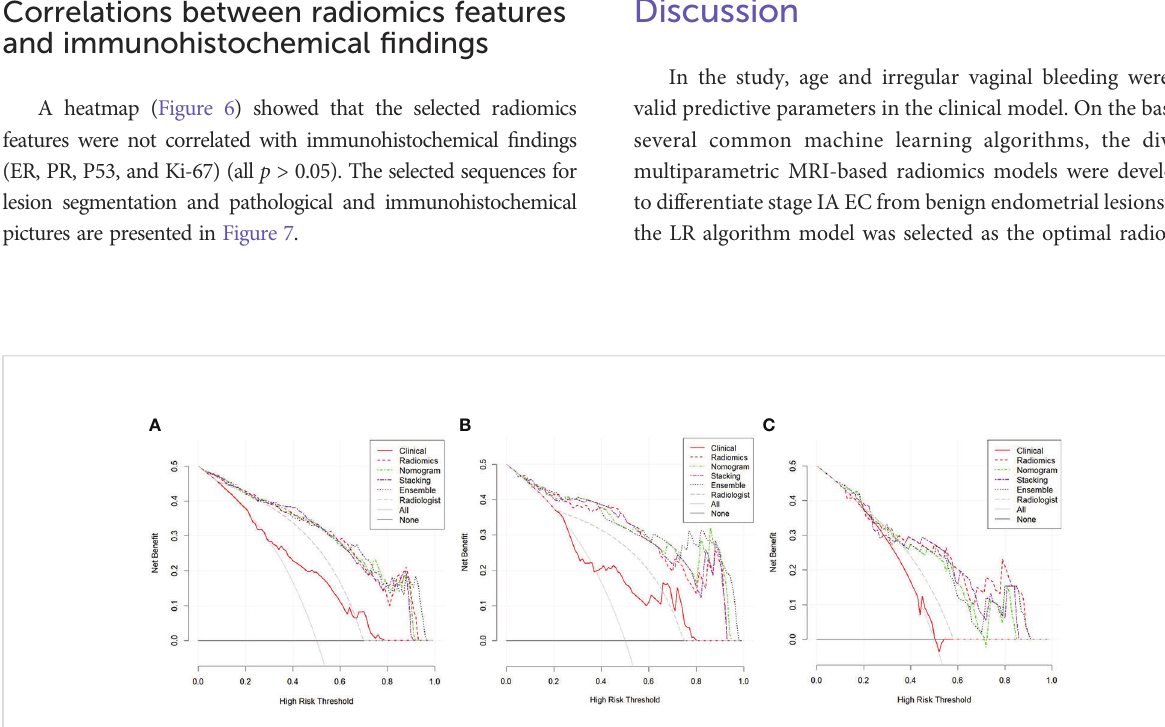
FIGURE 5 Clinical decision curves (CDCs) of different models and the radiologist in the training group (A) , the internal validation group (B) , and the external validation group (C)